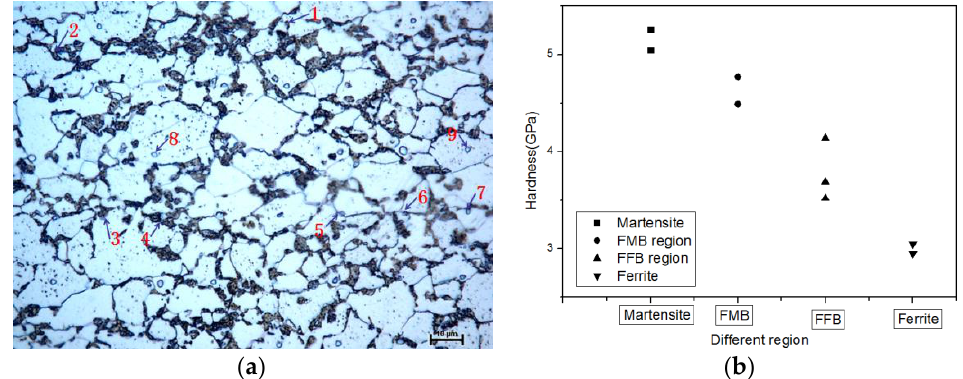
Figure 12. The hardness of individual regions: ( a ) indentation points of different regions, ( b ) hardness of different regions.